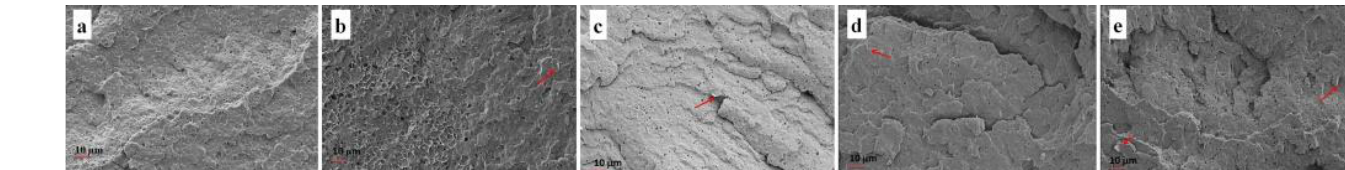
Figure 4. SEM images with magnification of 100 of nonfoamed samples of ( a ) as received neat co-PP; ( b ) 1 wt % xGnP incorporated nanocomposites via Method 1; ( c ) 2 wt % xGnP incorporated